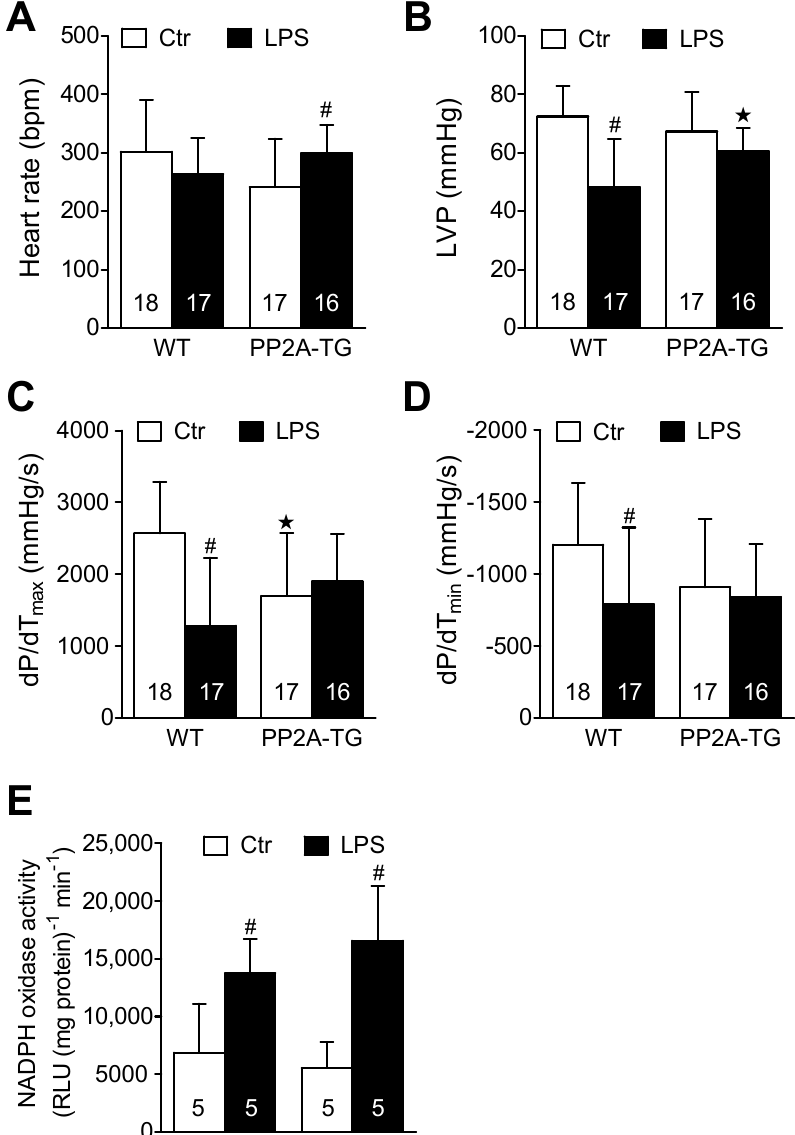
Figure 4. Isolated perfused hearts after LPS. Working heart preparations of wild type (WT) and PP2A overexpressing mouse hearts 3 days after intraperitoneal application of LPS (25 mg/kg) or NaCl solution as control. ( A ) Heart rate, ( B ) maximum left ventricular pressure (LVP), ( C ) maximum rate of left ventricular pressure development (+dP/dt), ( D ) maximum rate of left ventricular pressure decline ( − dP/dt), ( E ) activity of NADPH oxidase in cardiac tissue from WT or PP2A-TG. Numbers in brackets indicate the number of experiments ★ p < 0.05 vs. WT; # p < 0.05 vs. control (Ctr).